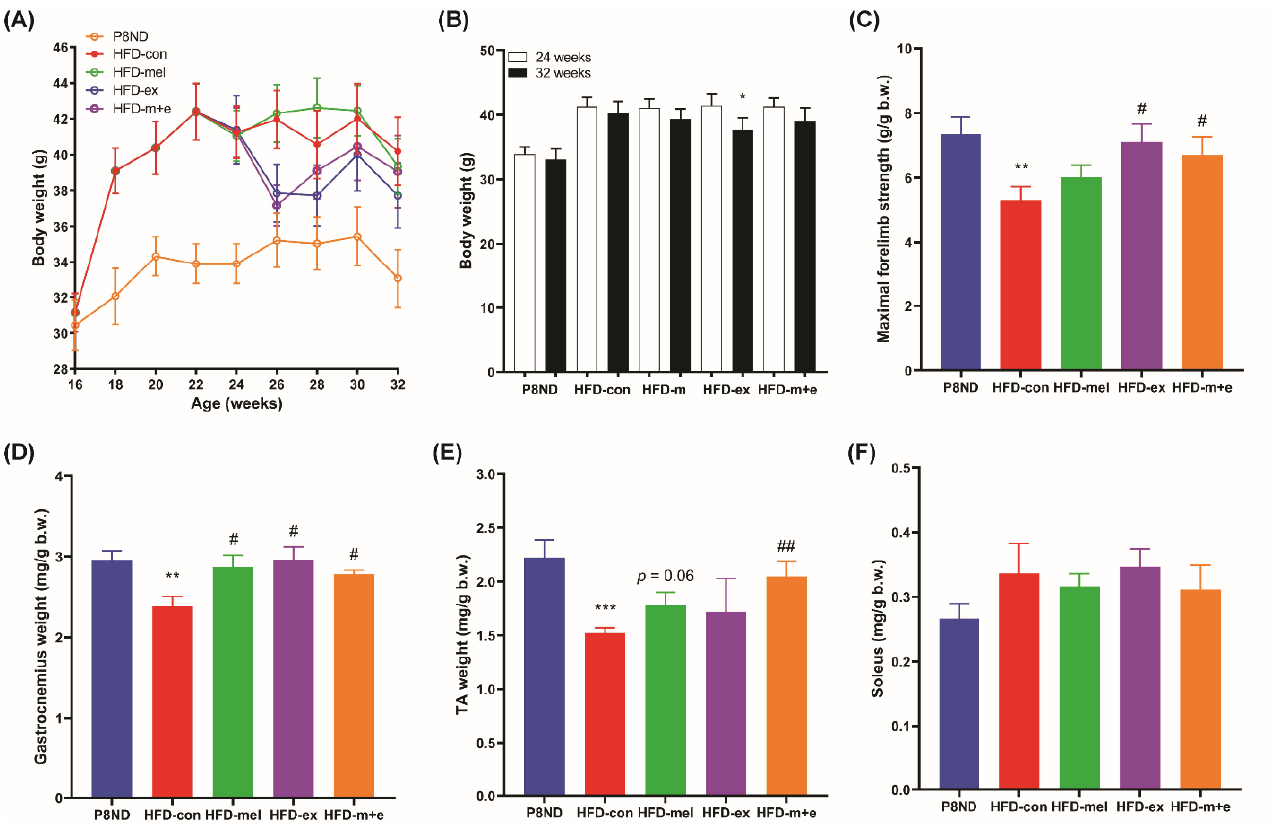
Figure 1. Melatonin and exercise training protected against the reduction in muscle weight and muscle strength in high-fat diet (HFD)-fed SAMP8 mice. Changes in body weight ( A ) during the experiment (16 – 32 weeks of age) and ( B ) after the experiment (n = 9 – 10); * p < 0.05 vs. 24 weeks by paired t -test. ( C ) Maximal forelimb strength and ( D – F ) relative muscle weight adjusted by body weight; ** p < 0.01, *** p < 0.001 vs. P8ND, ## p < 0.01, # p < 0.05 vs. HFD-con, by unpaired t -test. Data are presented as the mean ± SD.